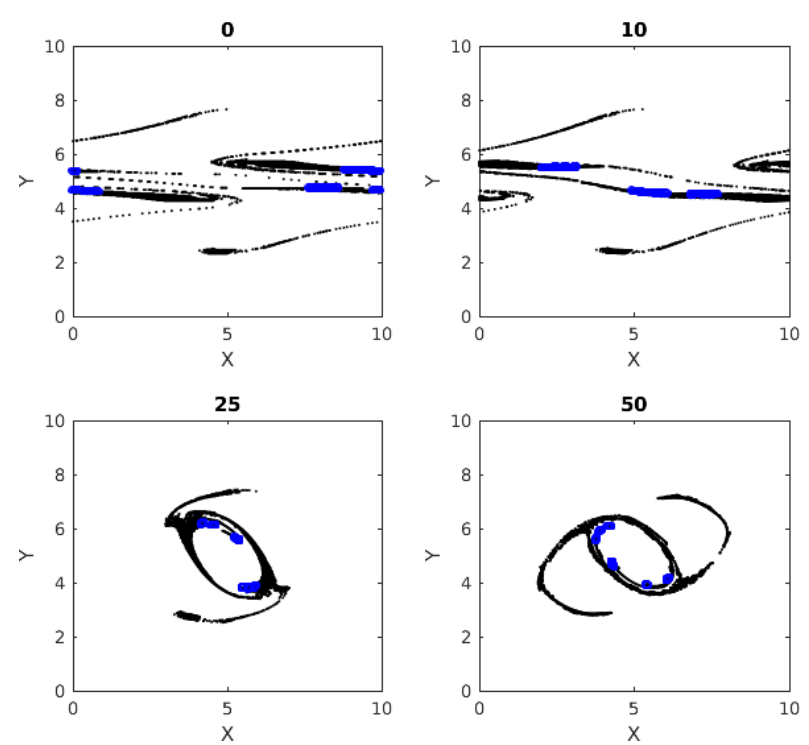
Figure 13. Dense clusters with (cid:15) = 40% and particles on uniform rectangular grid.